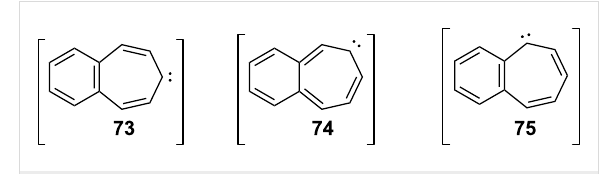
Figure 5: Possible benzo[7]annulenylidenes 73 – 75